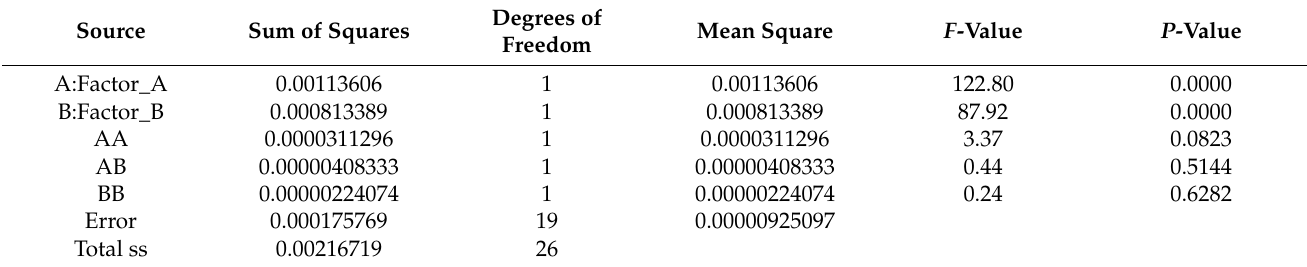
Table 3. ANOVA results for the response surface regression model on GSH